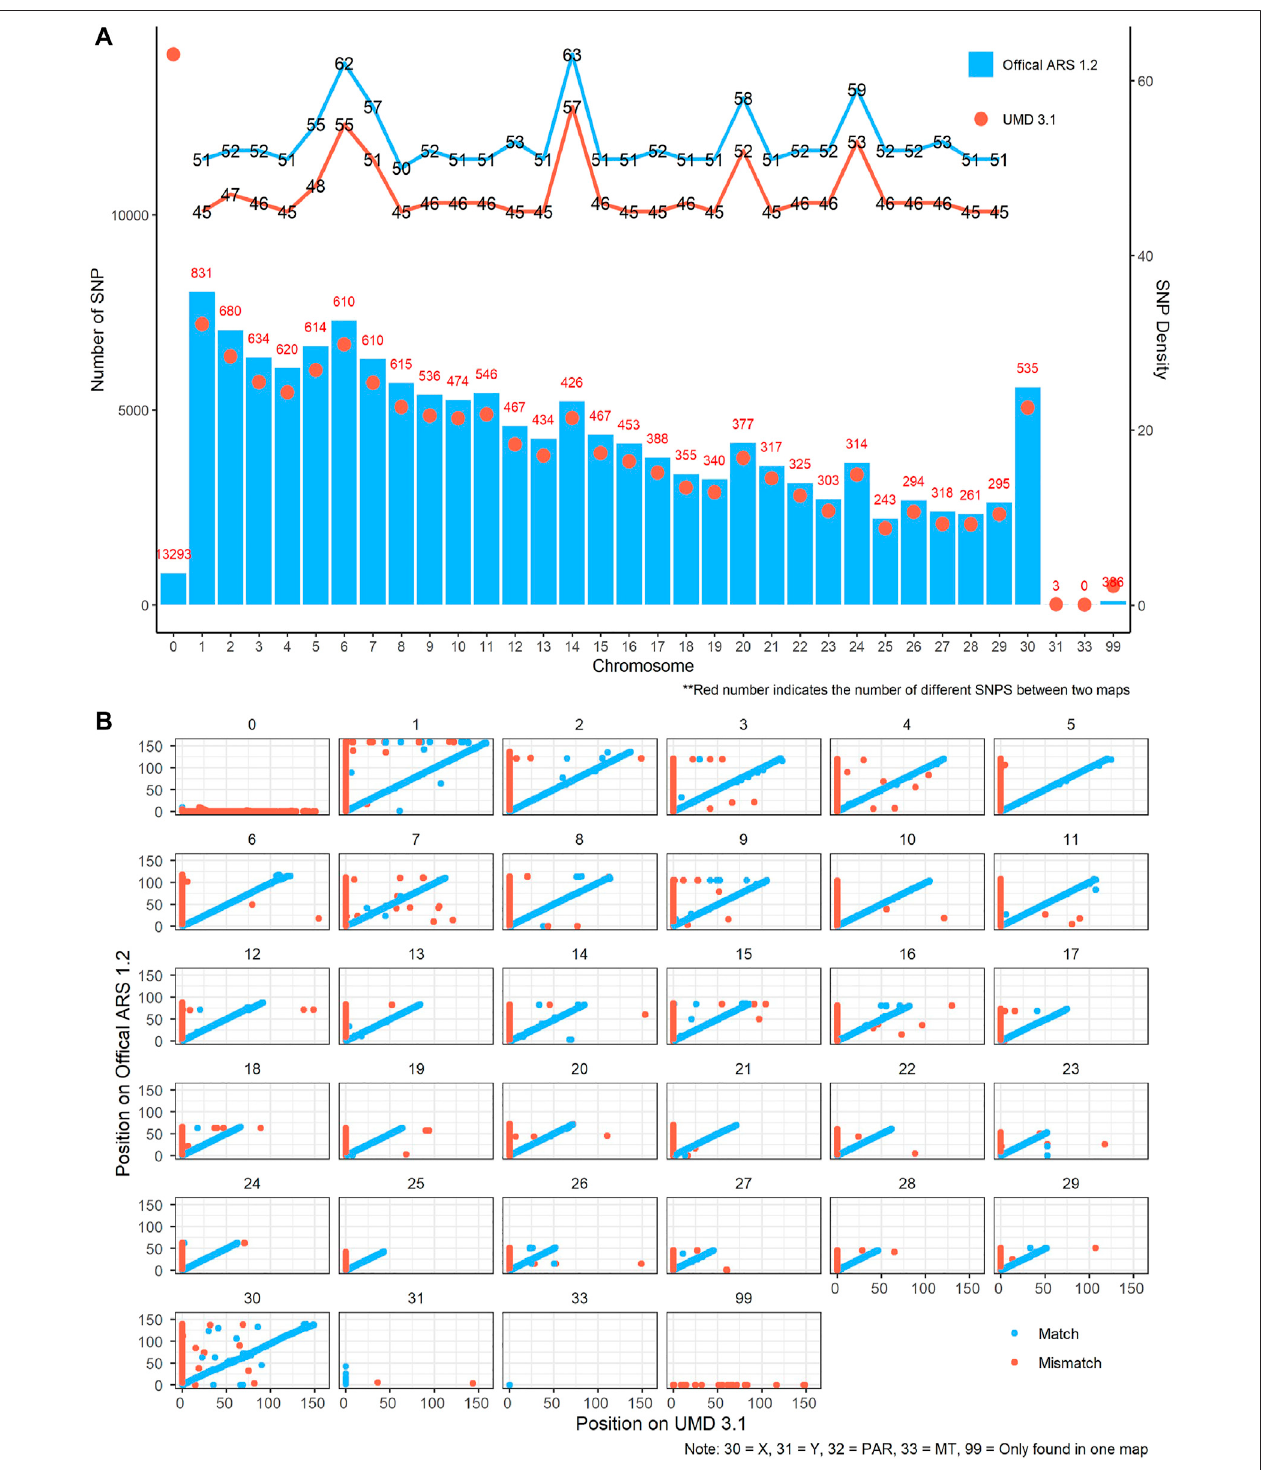
FIGURE 1 | Comparison of single-nucleotide polymorphism (SNP) map between the UMD 3.1 and ARS-UCD 1.2 version. (A) SNP number and density difference betweenthetwomapsoneachchromosome.BlueandredlinesindicatetheSNPdensityoftheARSandUMDmaps,respectively.Bluebarsandreddotsrepresentthe quantity of SNP in Athe RS and UMD maps, respectively. (B) SNP position difference between the two maps on each chromosome. Blue points indicate the SNP matching on same chromosomes in the two maps, while the red points do the opposite. The points not on the diagonal line indicate that the order of SNPs in the two maps differ greatly on the